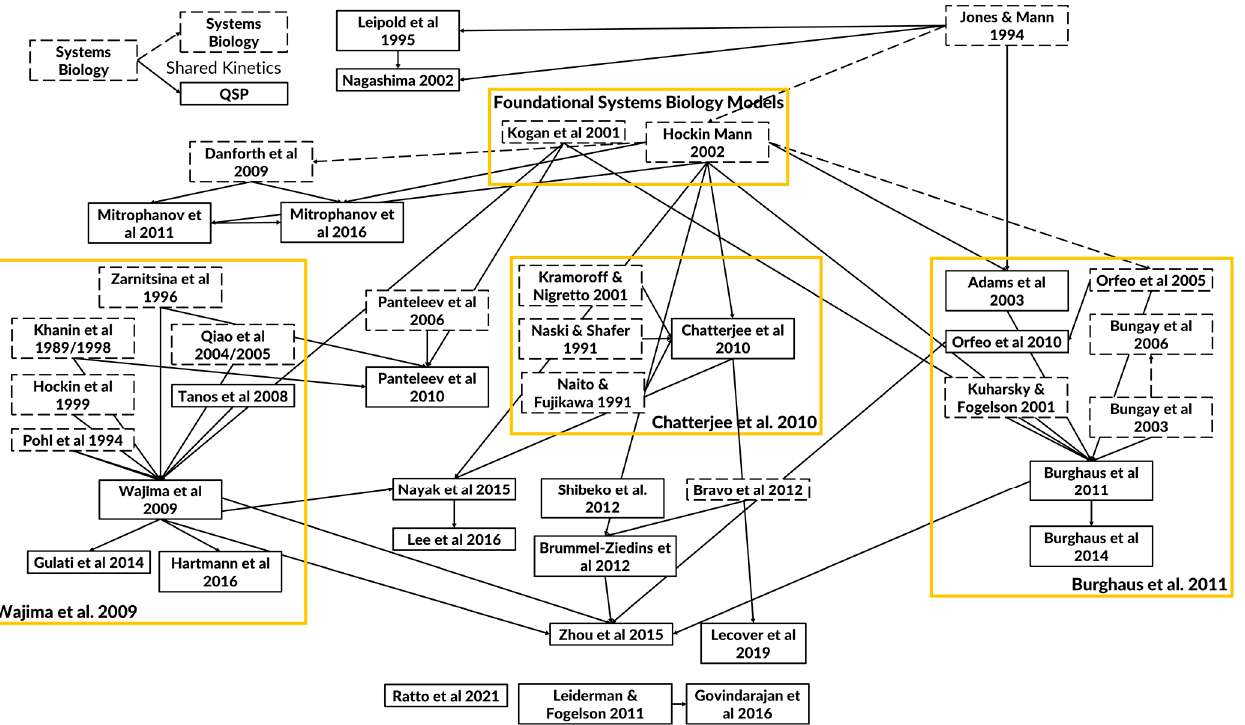
Figure 2. Diagram of key quantitative systems pharmacology (QSP) models of the coagulation cascade. The arrows depict how the whole or parts of the model (e.g., kinetics) have been adopted and modified between published models. The solid boxes indicate QSP models, and the dashed boxes indicate SB models. The solid arrows are used to link QSP models that share model equations and parameters from the original to the adopted model. The dashed arrows are used to link SB models. Models that are listed without any connections do not share signi fi cant common components. From